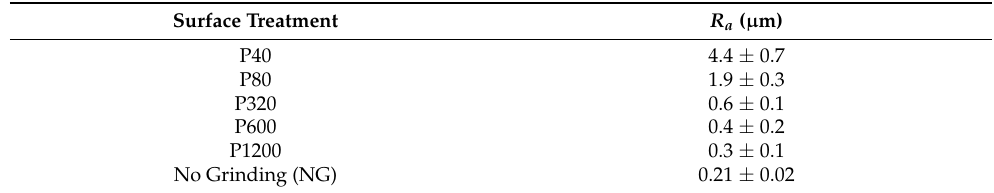
Table 4. Aluminium roughness (average ± standard deviation of R a values) after different grind- ing